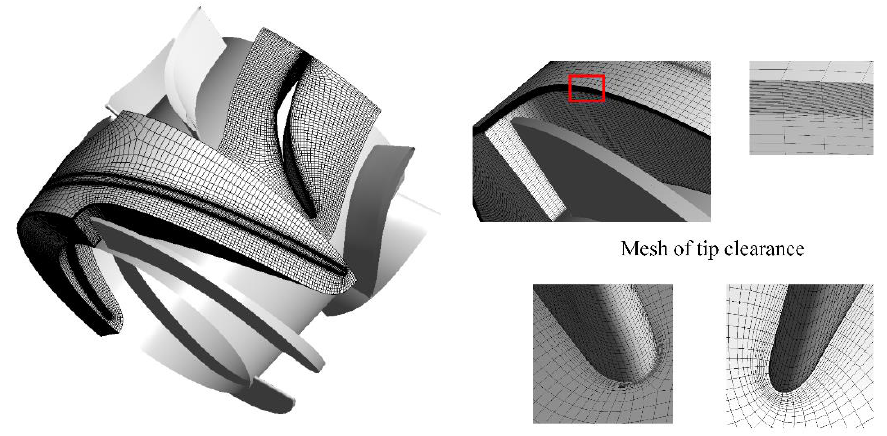
Figure 3. Computational mesh.